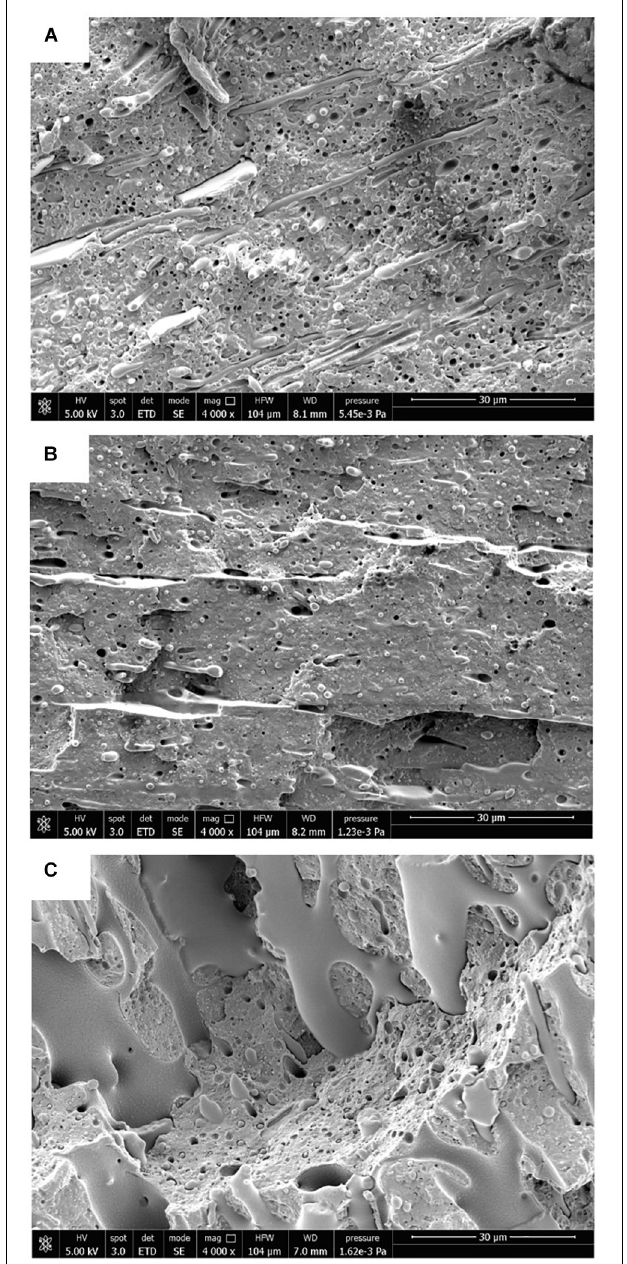
FIGURE 3 | SEM micrographs of plasticized ternary blends in comparison with (90-10)+10POE: (A) (90-10)+10POE; (B) (90-10-10)+10ATBC; (C)